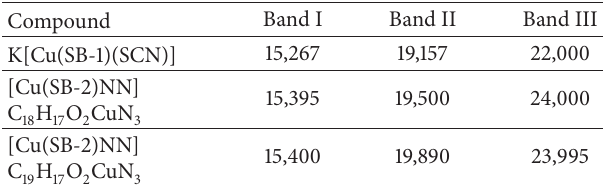
Table 3: Electronic spectral data of the complexes (band maxima in cm −1 ).